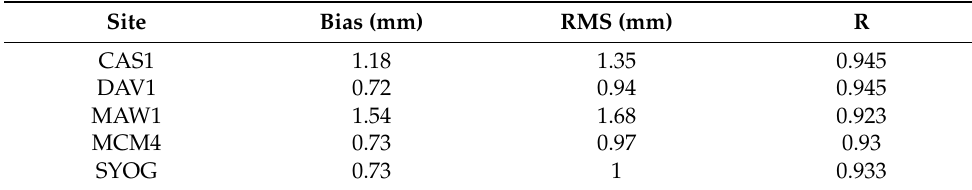
Table 2. Statistical results of the comparison between GNSS-derived PWV and radiosonde-derived PWV at the five collocated sites from 2001 to 2018.